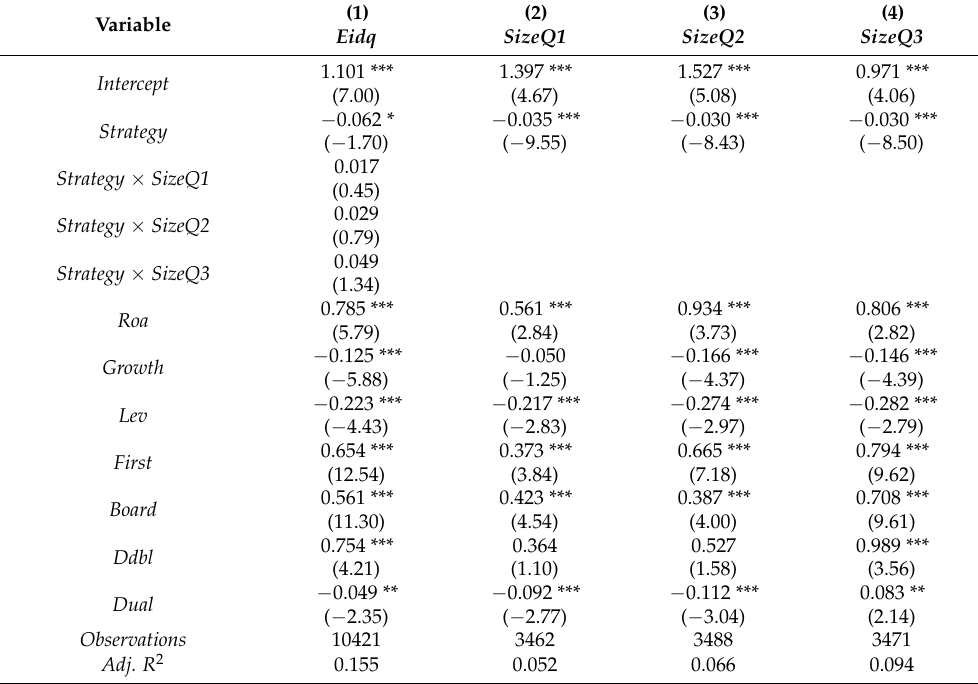
Table 9. Business strategy and environmental information disclosure quality: Groups test of firm size.